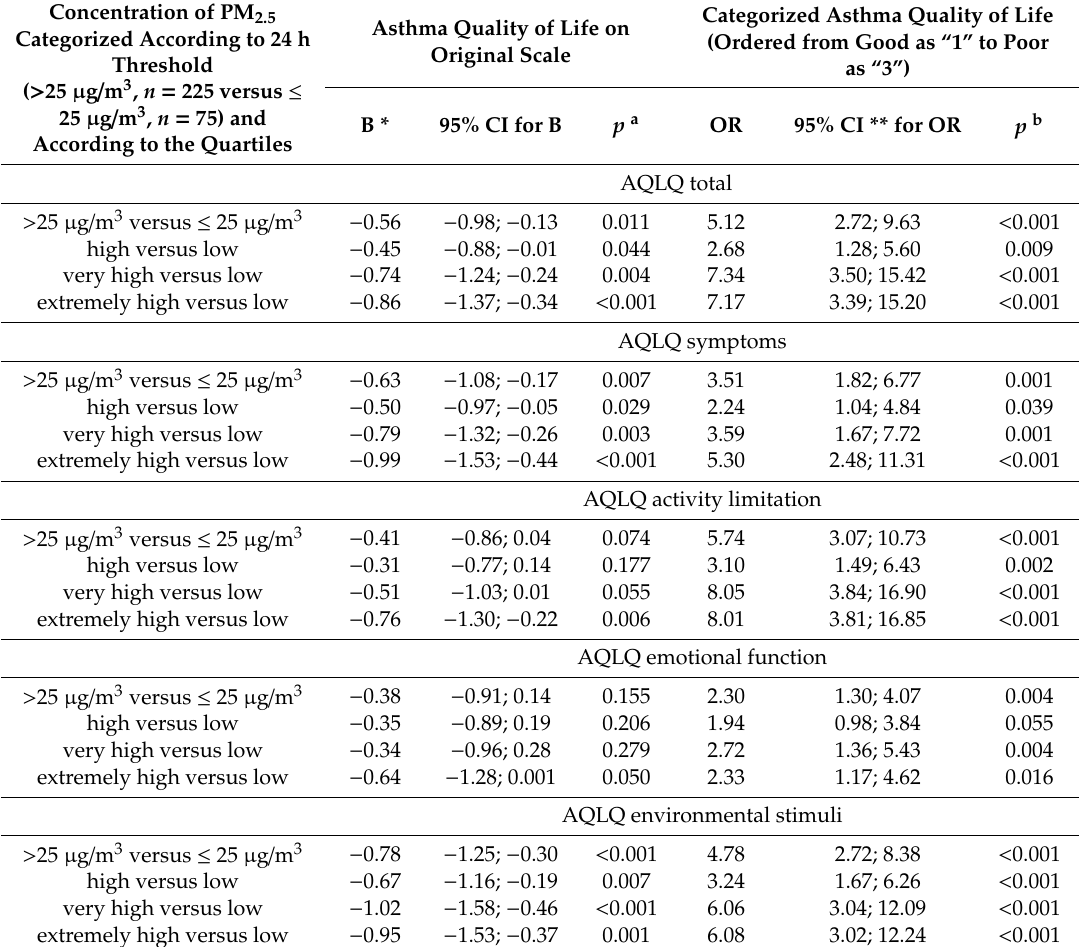
Table 2. Impact of categorized concentration of PM 2.5 on asthma quality of life (AQLQ) and the risk of poor asthma quality of life, adjusted to potential